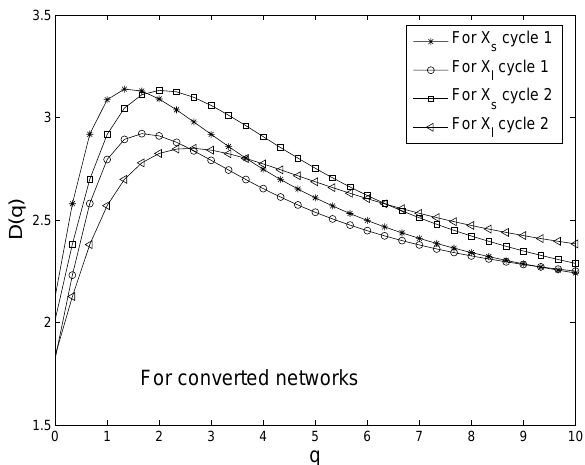
Fig. 6. The D(q) curves of the converted horizontal visibility graphs of the X l and X s